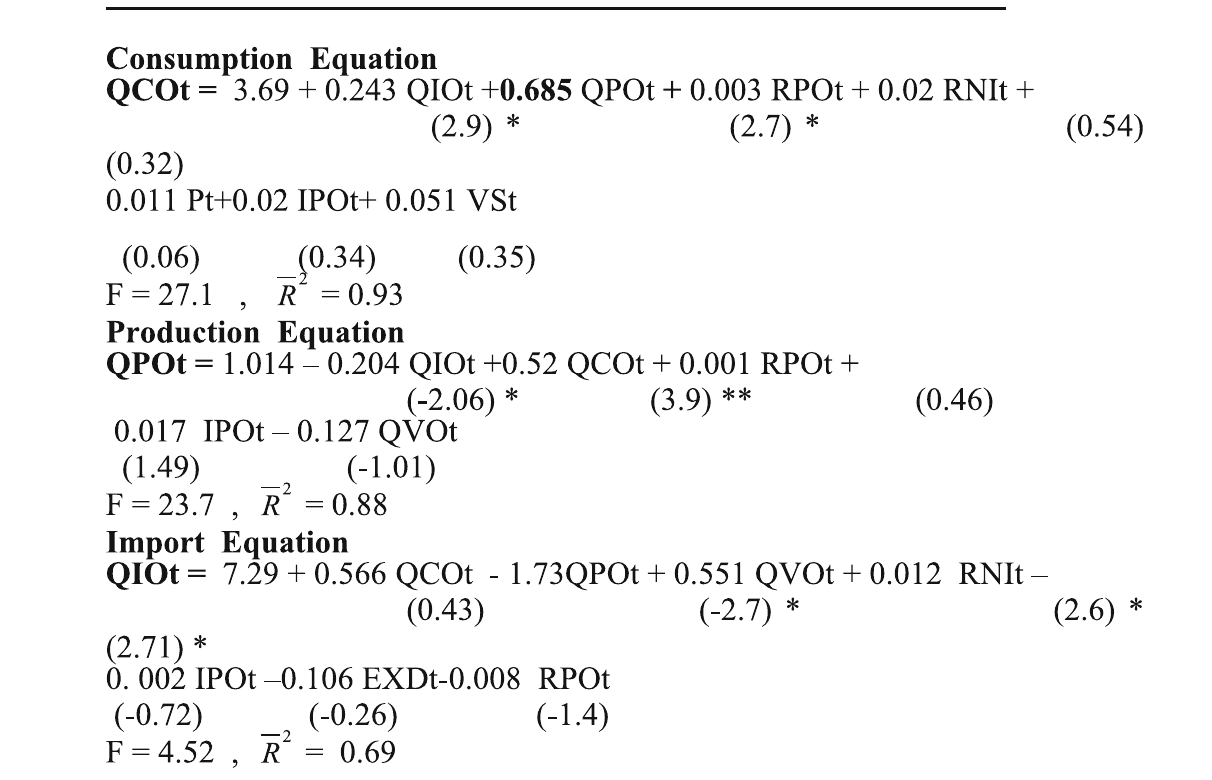
Table 3 Estimates of structural equations of the standard model. Source: calculated from Table